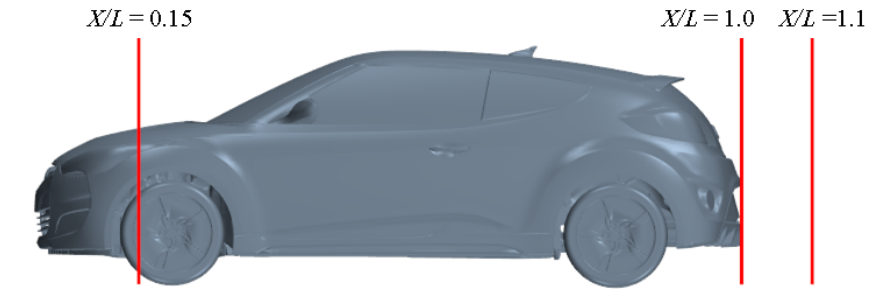
Figure 17. Locations of selected plane sections.